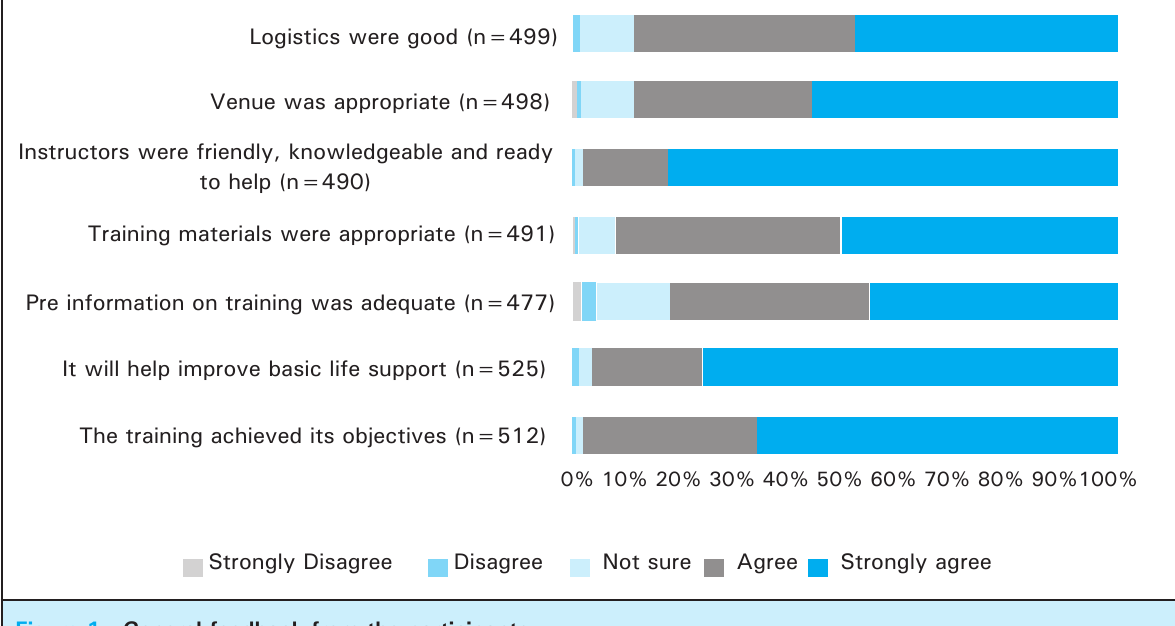
Figure 1. General feedback from the